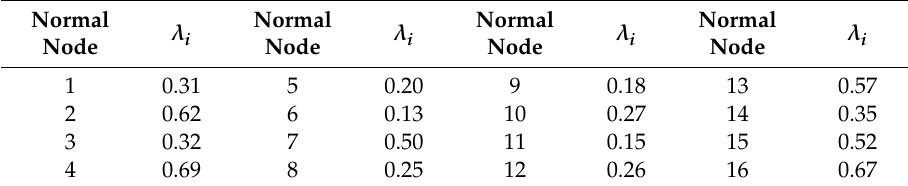
Table A2. Value of parameter λ i for each normal node.